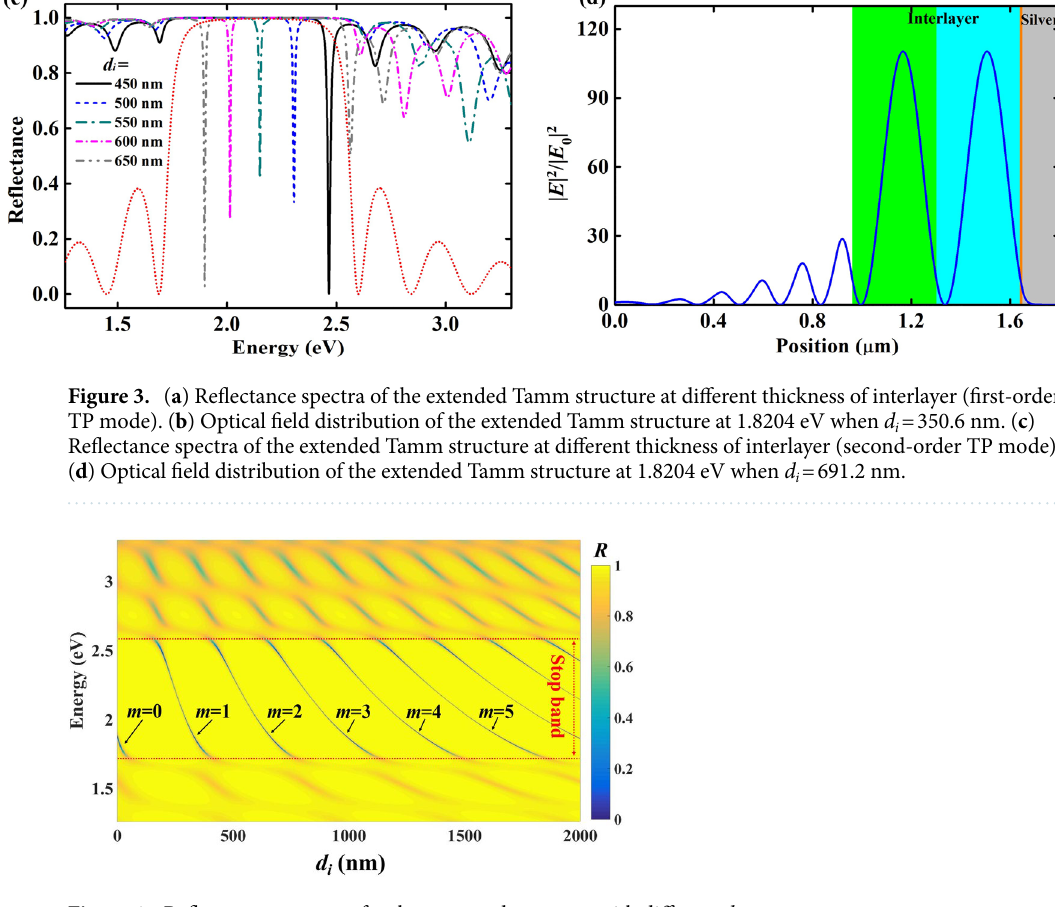
Figure 4. Reflectance spectrum for the proposed structure with different d i